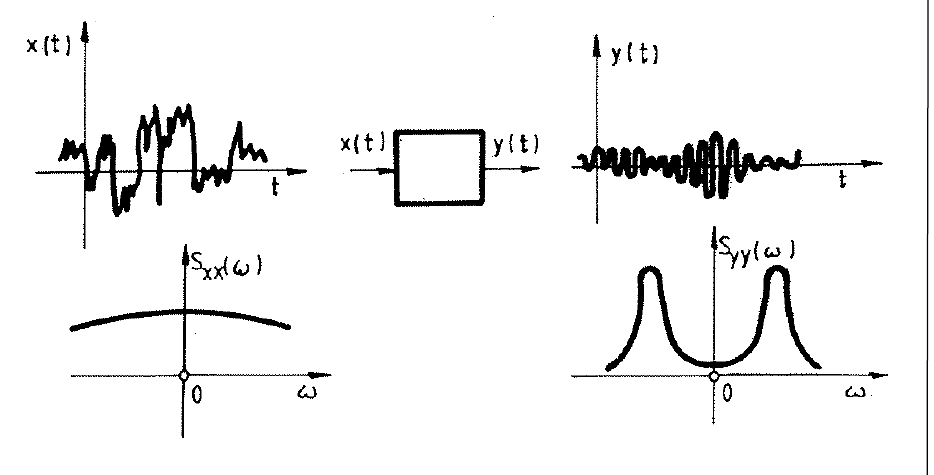
Figure 2 – Changes in the input signal through the system with the corresponding